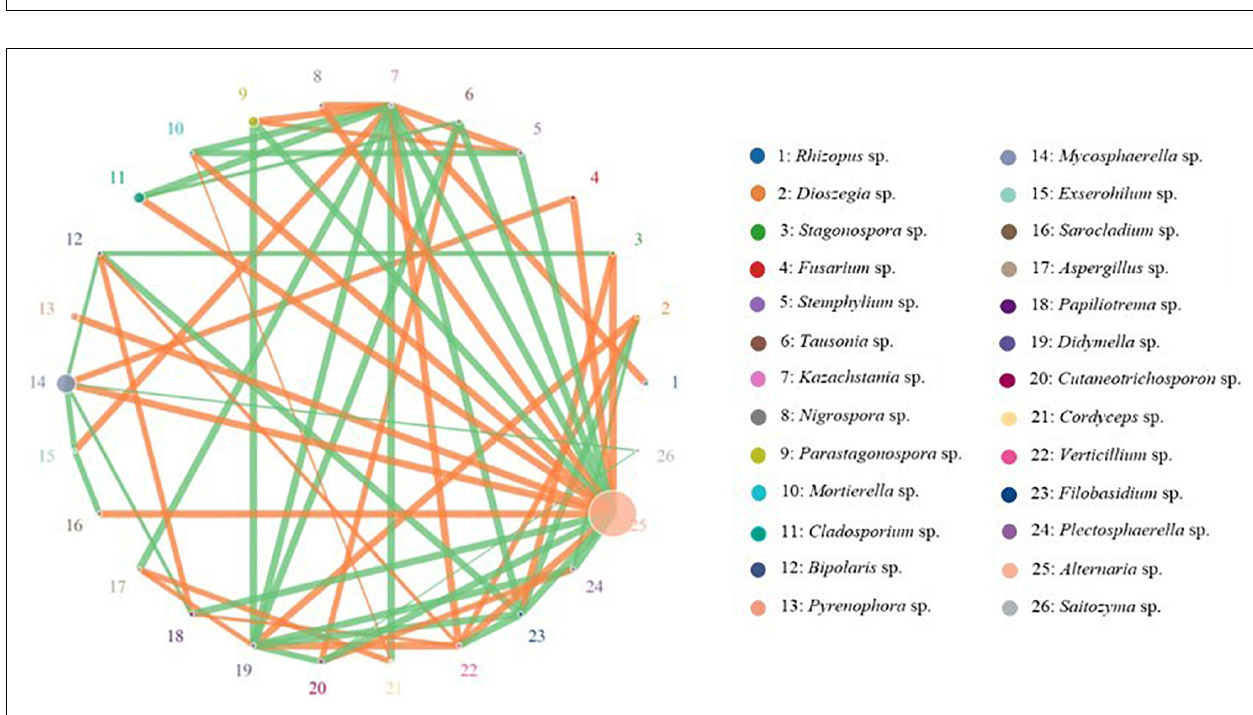
FIGURE 7 | Fungi Functional Guild (FUNGuild) of relative abundance in different oat seed samples.